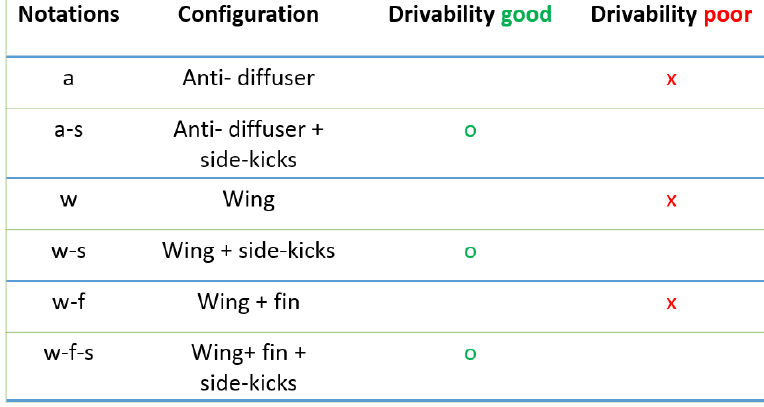
Figure 6. Subjective